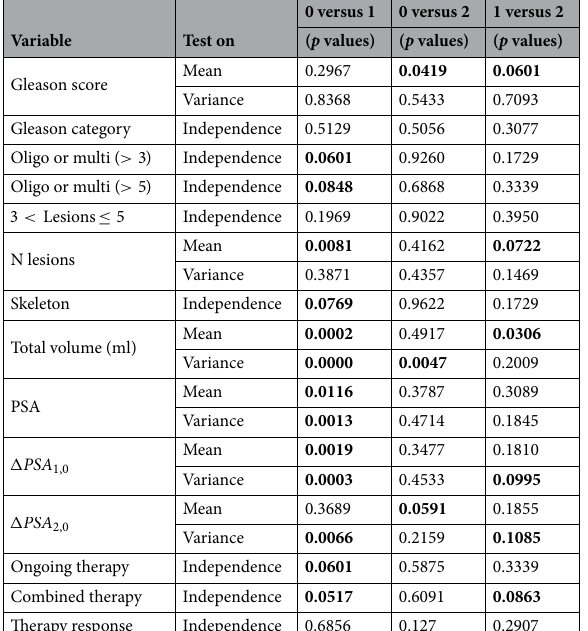
Table 1. Significance in terms of p values of the statistical tests between cluster 0 and cluster 1, cluster 0 and cluster 2, cluster 1 and cluster 2 in the proposed pipeline: non-parametric/parametric tests on difference of averages and variances were performed for (non-normal/normal) numerical variables while tests on category independence were performed for categorical variables. Significant values are in